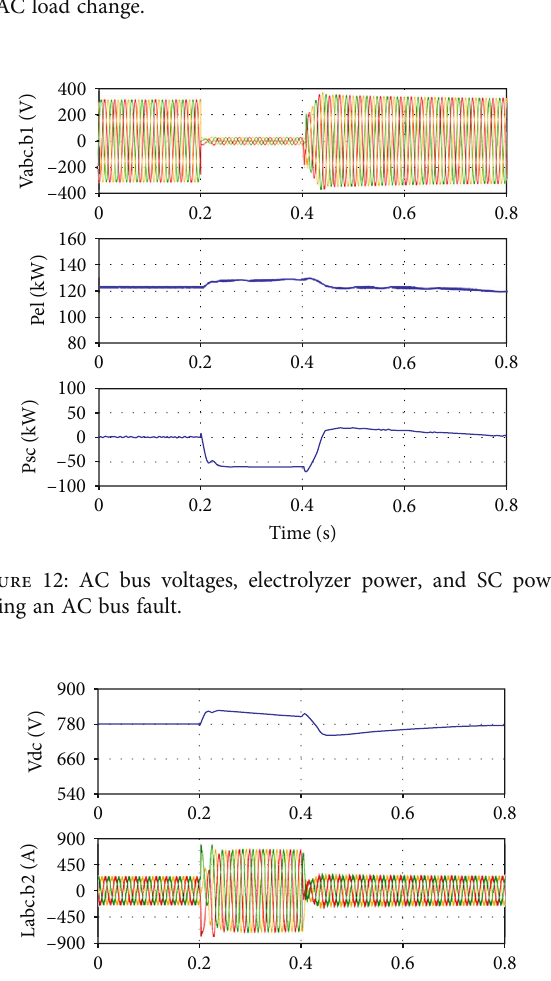
Figure 11: SC power, DC-link voltage, and AC bus voltage during an AC load change.